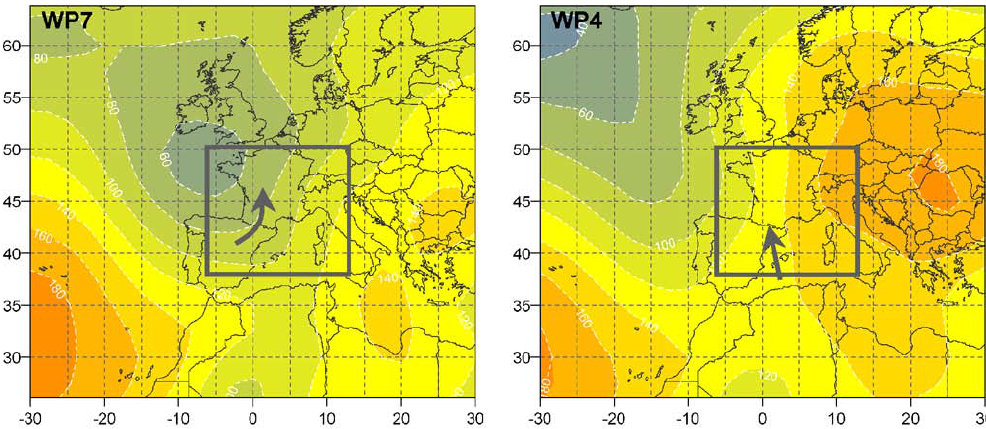
Fig. 2. Average geopotential height at 1000 hpa for the weather patterns 7 and 4 of the EDF2006 classification (from Garavaglia et al., 2010). The arrows indicate the airflow, near the surface, induced by the prevailing synoptic